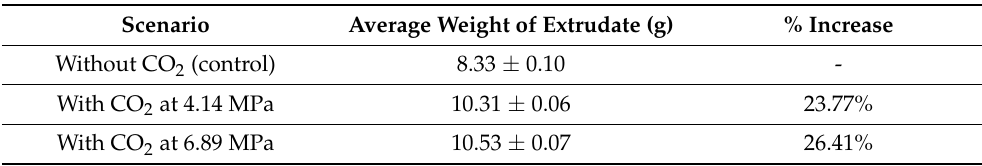
Results are mean ± standard deviation, n =